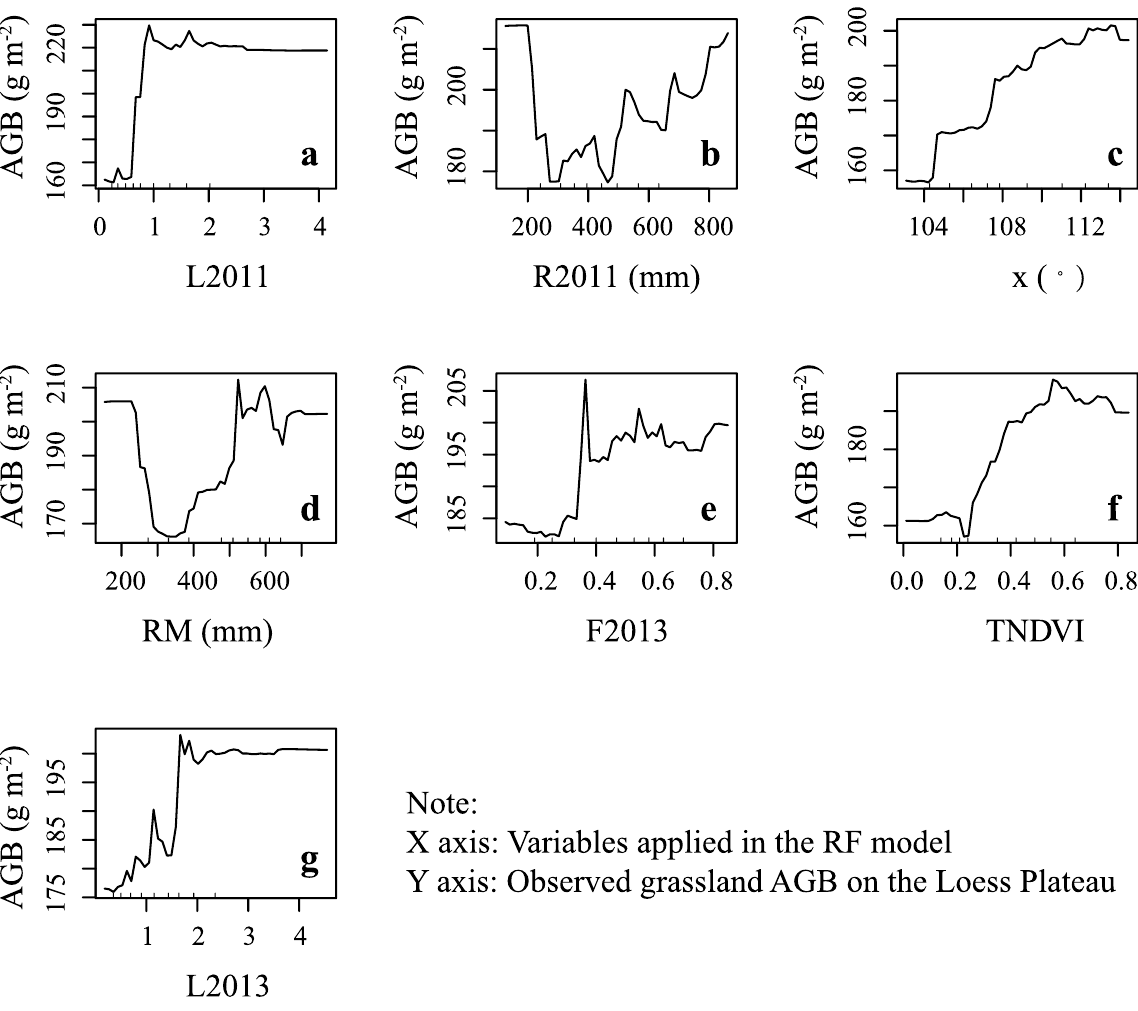
Figure 4. Partial dependence of various factors on observed grassland AGB. The meaning of factors referred to Table